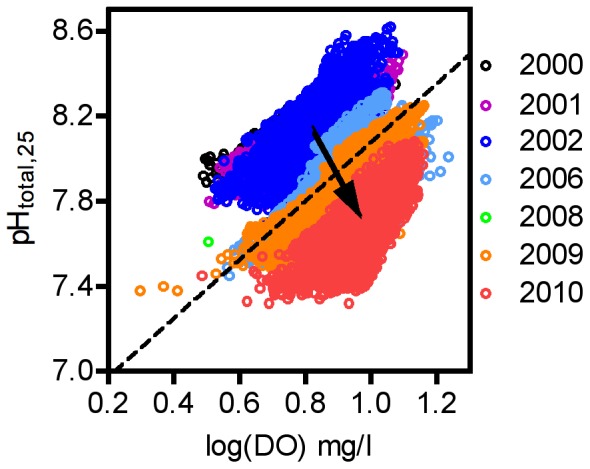
Patterns in the relationship between dissolved oxygen and pH within and among years.Years when oxygen probe (2003, 2005, 2007) or pH probe (2004) malfunctioned are not included. Note that relationships within years (single colors) follow the positive relationship expected between the two from the photosynthesis-respiration relationship of CO2 and O2 (dashed line), but the trend across years (vector) does not follow this relationship.